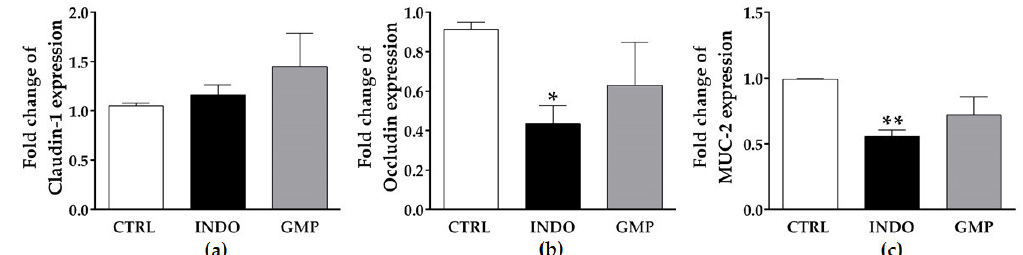
Figure 6. Effect of treatment with glycomacropeptide (GMP) on mucosal barrier integrity in rats with indomethacin-induced enteropathy. Intestinal expression level of claudin-1 ( a ), occludin ( b ) and mucin (MUC)-2 ( c ) relative to β-actin was analyzed by qPCR and presented as fold change. Data are presented as mean ± SEM. CTRL and GMP, n = 14; INDO, n = 11. * p < 0.05 and ** p < 0.01 INDO vs. CTRL.